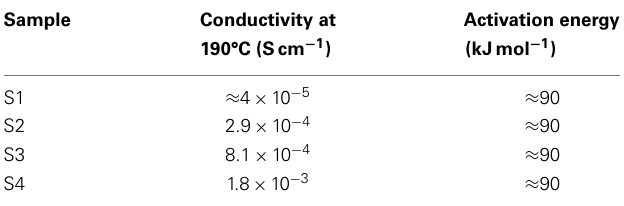
Table 2 | Proton conductivity and activation energy